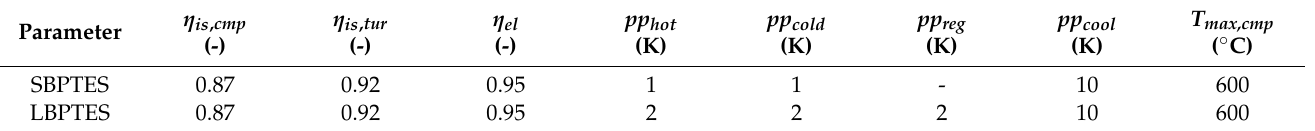
Table 1. Performance of turbomachines and heat exchangers. Pinch points ( pp , in K) represent the minimum value of the temperature difference that can be realised in the heat exchangers. T max,cmp in ◦ C is the maximum allowed temperature at the compressor discharge.